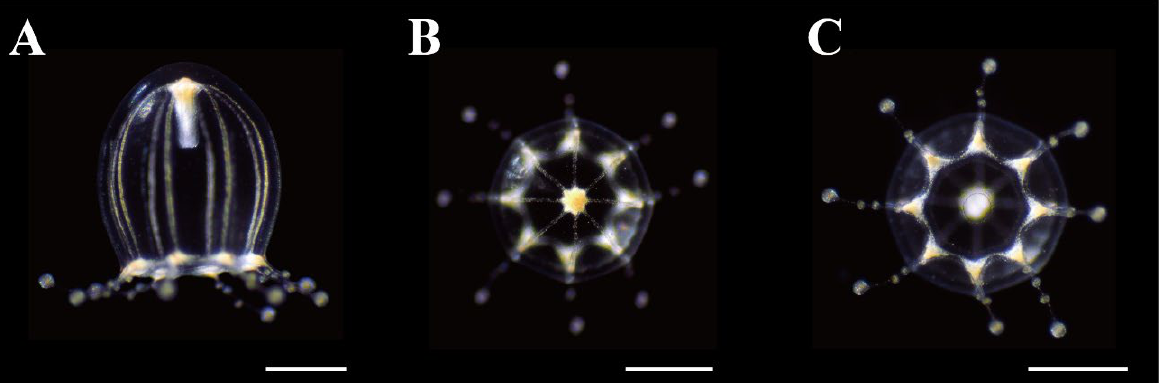
Figure 7. Live young medusae of Octorhopalona saltatrix sp. nov. (KBF-M32). ( A ) lateral, ( B ) apical and, ( C ) oral views. Scale bars: 0.5 mm.